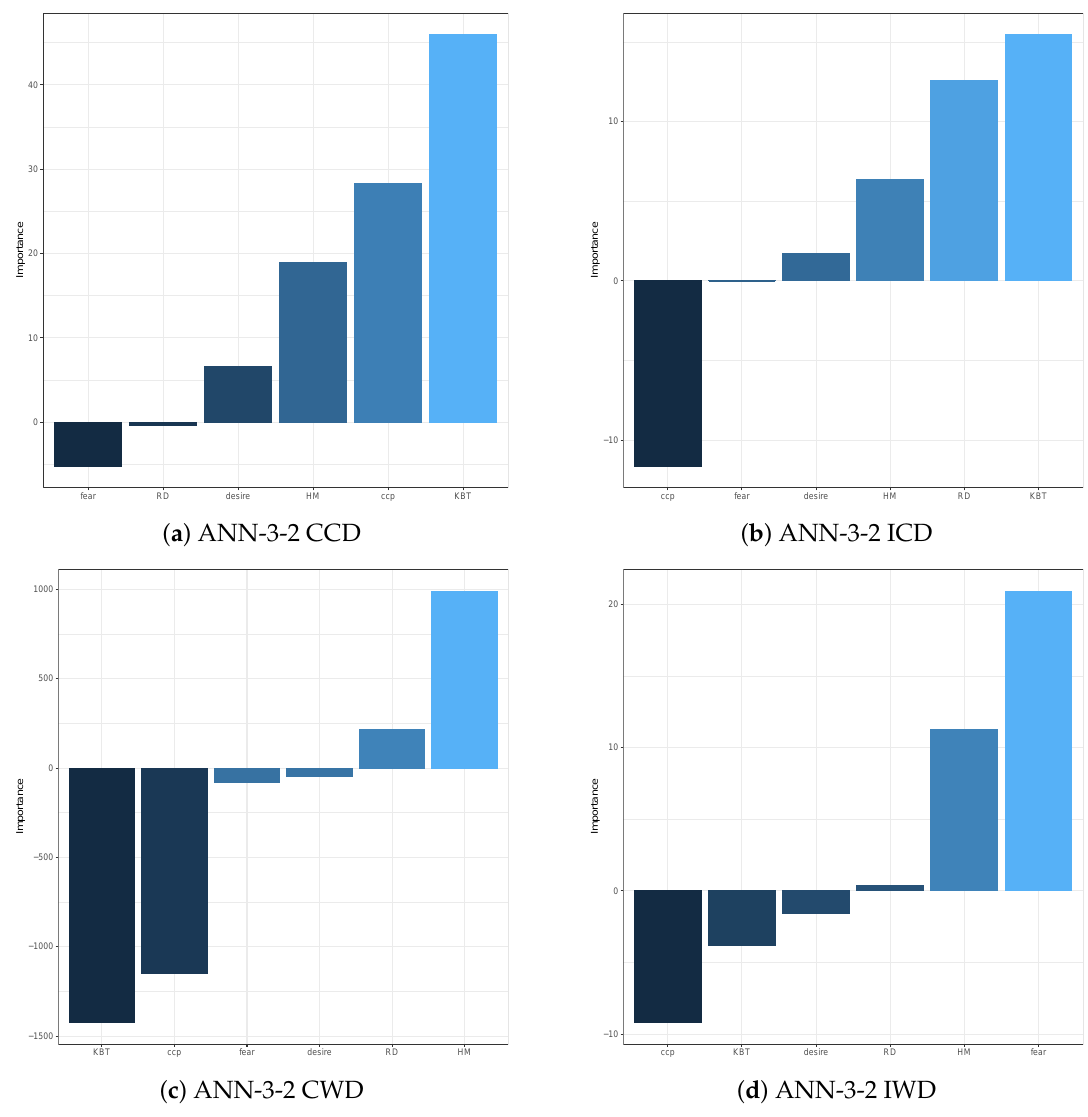
Figure 7. The variable importance measures by Olden function of the ANN model with two hidden layers, respectively, for each output variable, CCD, ICD, CWD and